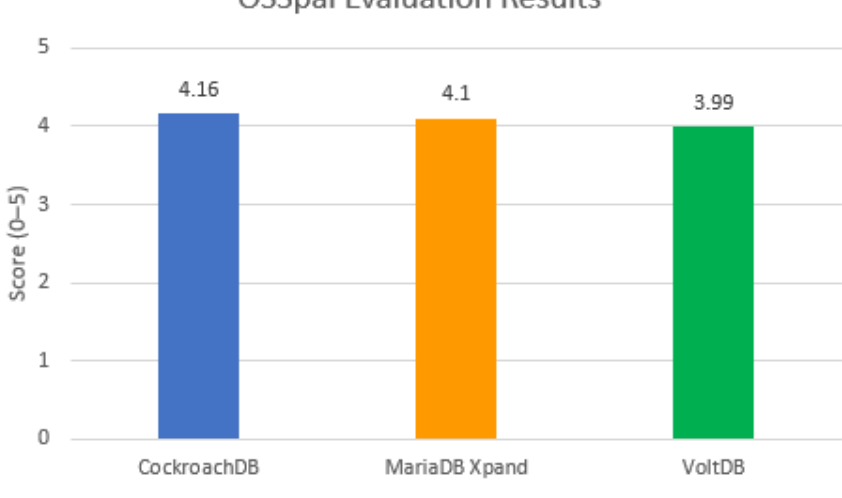
Figure 15. OSSpal evaluation results.